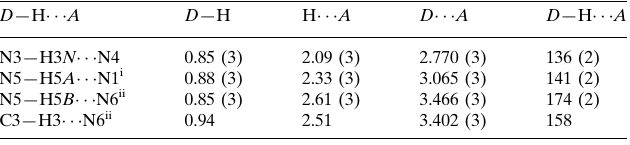
Hydrogen-bond geometry (A˚ , (cid:3)